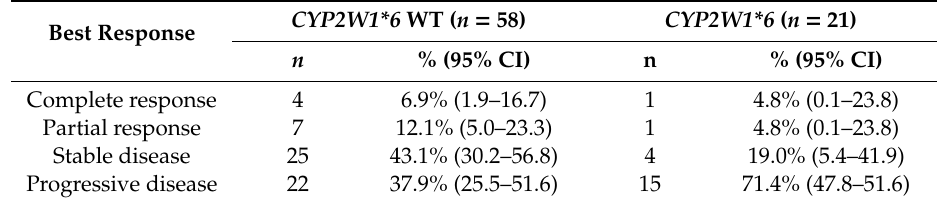
Table 5. Best overall response to mitotane treatment according to RECIST 1.1 criteria in group B ( n = 79).